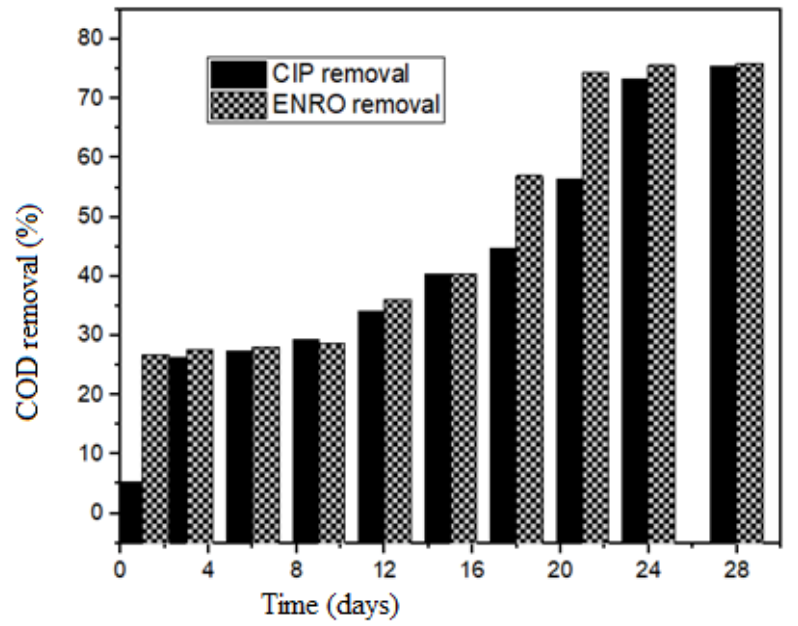
Figure 2. COD removal during biodegradation of wastewater at 35 °C, pH 7, and OLR at 3.5 kg.CODm − 3 .days − 1 .